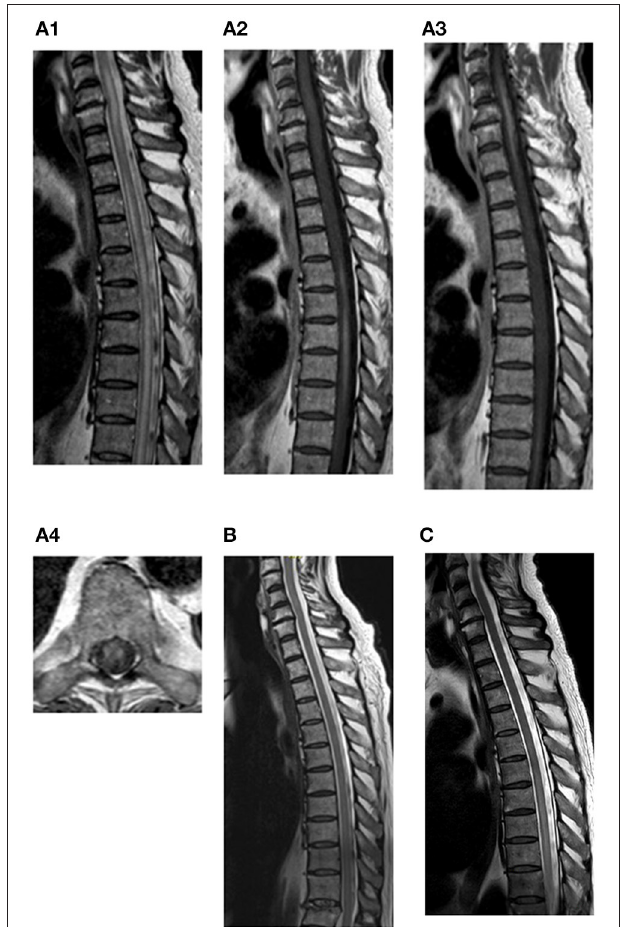
FIGURE 1 | MRI progression: at time of diagnosis (A1–4) , 3 days after last dose of p.o. MP (B) and 11 days after last dose of p.o. MP (C) . (A1) Sagittal T2-weighted MRI of columna totalis showing extensive LETM at cervical and thoracic levels. (A2) Sagittal T1-weighted MRI of columna totalis with contrast showing contrast enhancement at levels Th5–Th9. (A3) Sagittal T1-weighted MRI with contrast showing enhancement from C4-Th1. (A4) Axial T1-weighted MRI with contrast showing anterolateral multifocal contrast enhancement at level Th9. (B) Sagittal T2-weighted MRI of columna totalis showing almost complete regression of LETM. No contrast enhancement on T1 (not shown). (C) Sagittal T2-weighted MRI of columna totalis with relapsing LETM on levels Th5–Th11. Contrast enhancement on T1 weighted MRI (not